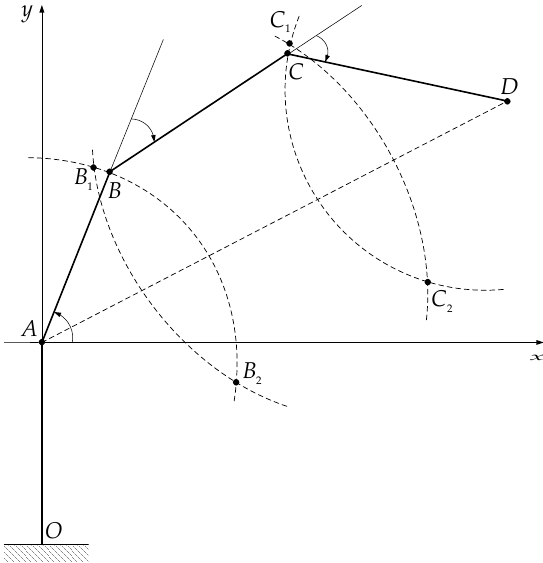
Figure 5. Redundant range diagram.